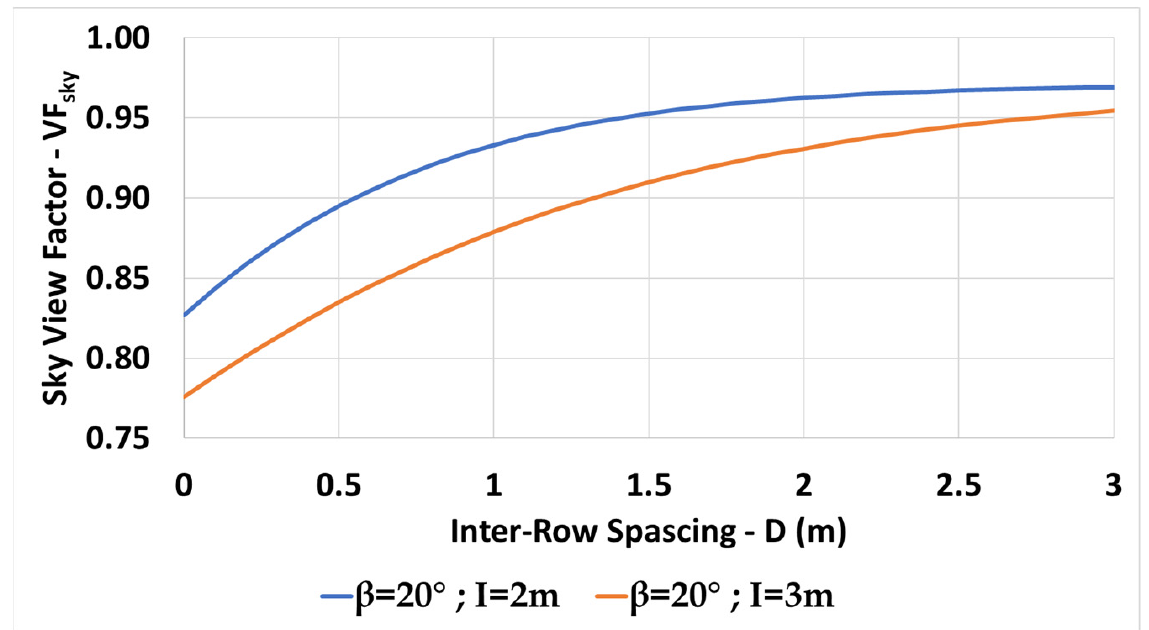
Figure 20. Variation of sky view of factor of a collector, on horizontal plane, with distance from a building of height, 𝐼 , collector behind a building.